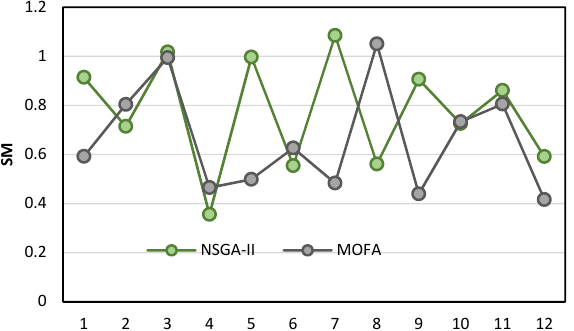
Figure 8. Comparison of NSGAII and MOFA based on to the spacing metric.